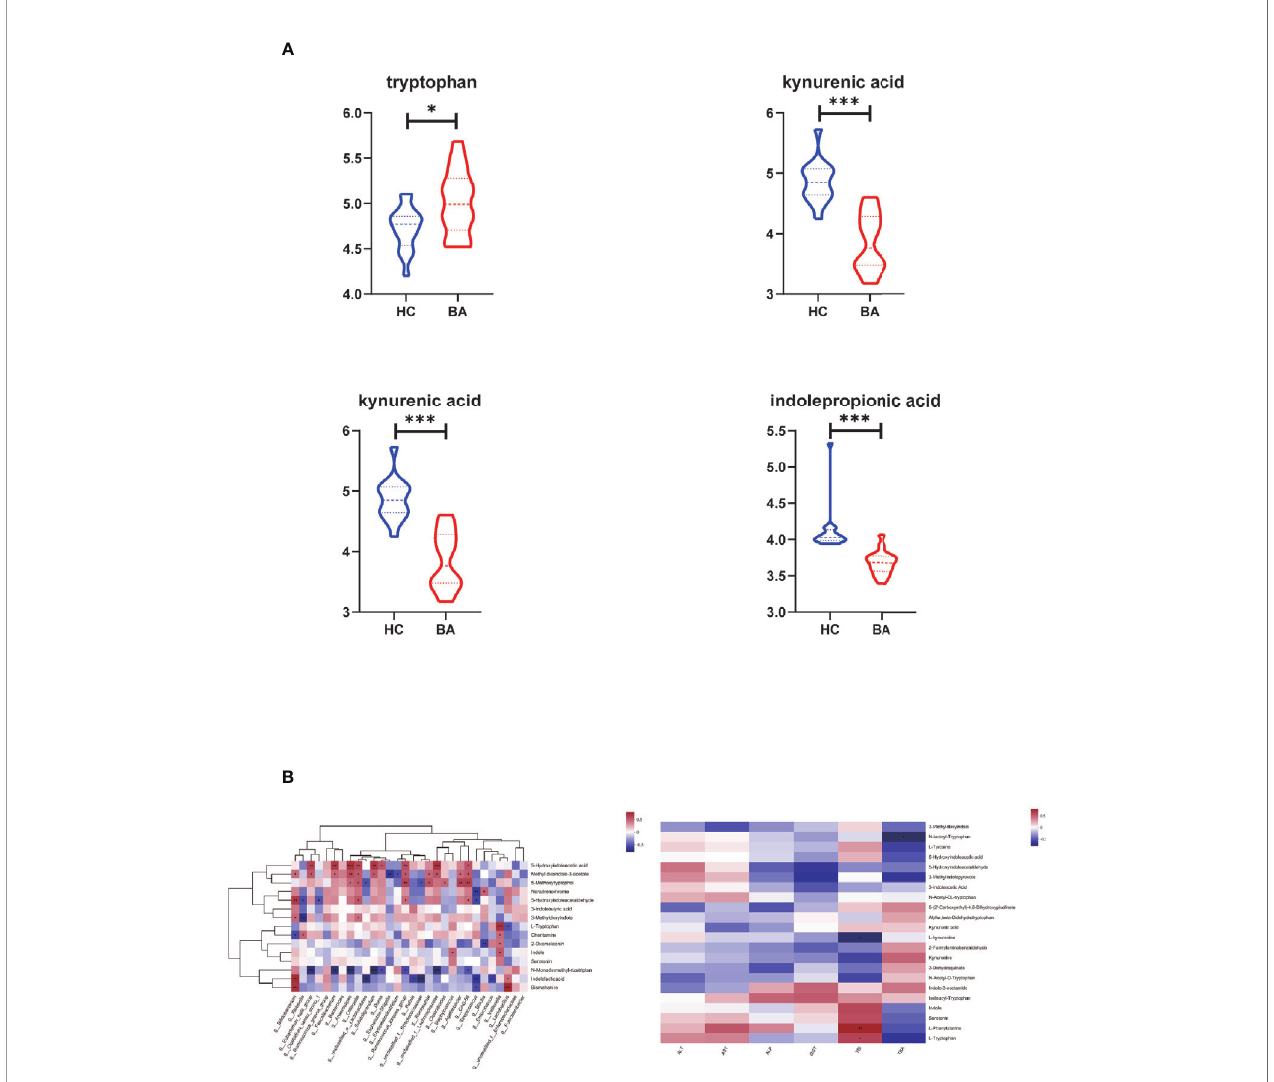
FIGURE 4 | (A) Differential metabolites related to tryptophan metabolism in biliary atresia and control groups (*P < 0.05, ***P < 0.001) (BA, biliary atresia; HC, controls). (B) The relationship between altered species, metabolites, and liver function indicators. Left: Associations of differential metabolites with top 30 genera in abundance. Right: Associations of differential metabolites with liver function indicators (*P < 0.05, **P < 0.01, ***P <